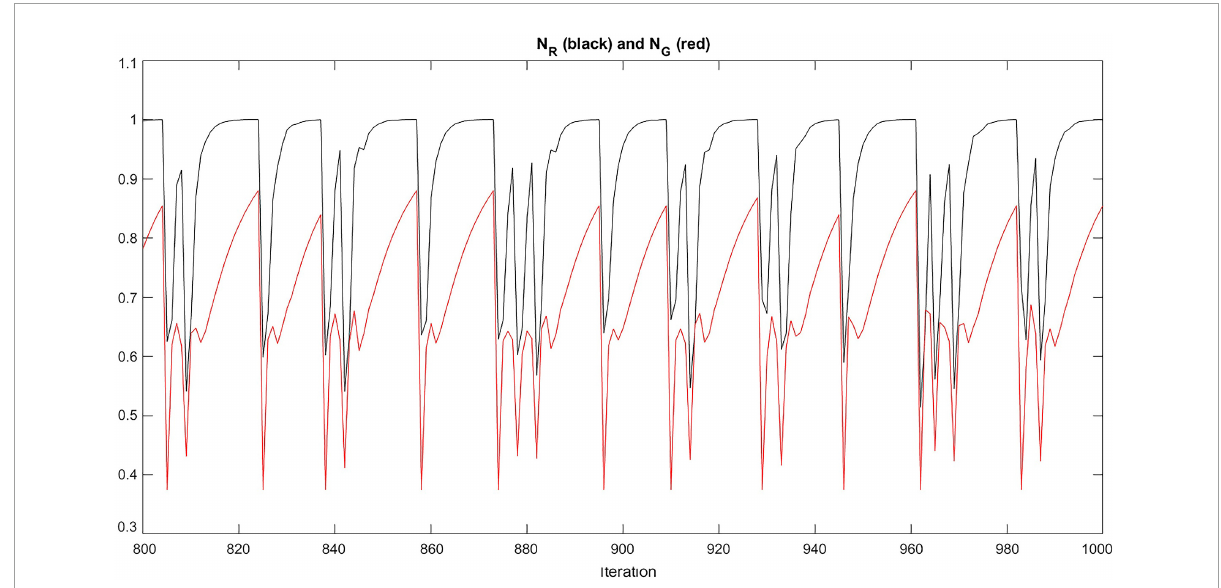
FIGURE5 Oscillation of N R and N G . For each dimension, N R and N G oscillate around a baseline. The graph represents the oscillation of N R (in black) and N G (in red) for ambivalence 0.7 over 200 iterations.